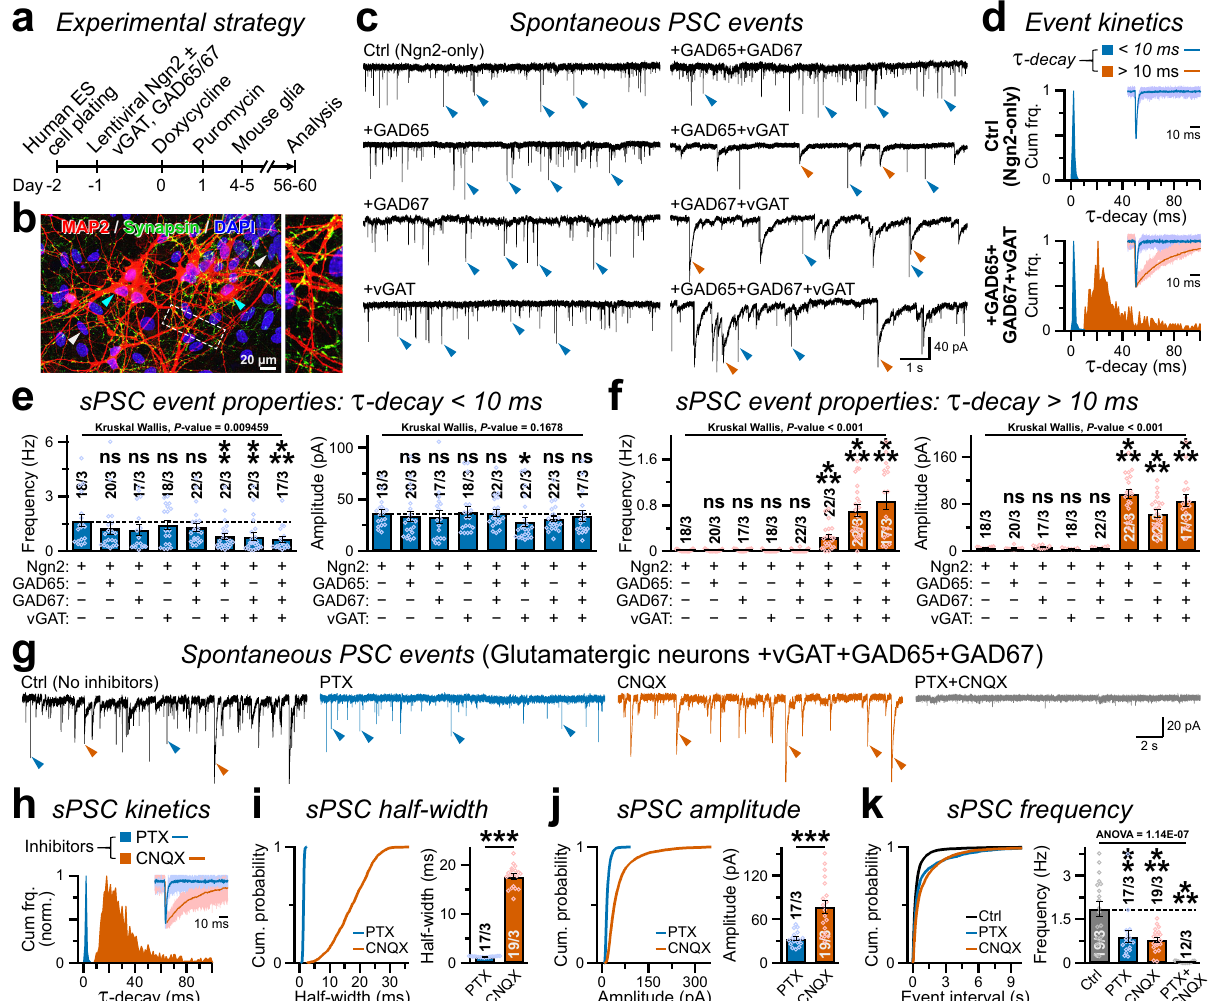
Fig. 1 Enzymatic synthesis and synaptic release of GABA by de fi ned factors. a Neurogenesis was induced in H1-ES cells by lentiviral Ngn2 expression, co- infected with additional viruses encoding vGAT, GAD65, and/or GAD67; neurons were co-cultured with mouse glia and analyzed at day 56 – 60. b An example image of Ngn2-induced human neurons (cyan arrowheads) co-transduced with V57 factors, immunolabeled for MAP2, Synapsin, and stained for nuclear DAPI (white arrowheads). The MAP2-negative and DAPI-stained population indicate co-cultured mouse glial cells. Inset, dotted box magni fi ed on right. c , d Sample traces of sPSCs recorded from indicated conditions c , and normalized cumulative frequency of τ -decays d for fast vs. slow (blue vs. red arrowheads) events. Insets in d , example waveforms of 10 scaled and overlaid sPSCs (light shade) with corresponding averages (dark shade) for control (top) vs. V57 (bottom). e , f Average frequency (left) and amplitude (right) of sPSC events with fast ( e , τ -decay < 10 ms) vs. slow ( f , τ -decay > 10 ms) decay kinetics, as recorded from human neurons expressing indicated factor combinations. g , h Representative traces g and cumulative histogram of τ - decay h of sPSCs recorded from Ngn2-neurons co-expressing V57 factors, before (Ctrl) and after acute treatments with PTX and/or CNQX (as annotated). i – k . Cumulative probabilities (left) and average values (right) of sPSC half-width ( i ), amplitude ( j ), and event frequency ( k ), measured in the absence (Ctrl) or presence of inhibitors, PTX, CNQX, or both PTX + CNQX. All data are presented as means ± SEM, with number of cells patched / independent batches. Individual data-points are provided as color-matched open circles. For panels e , f , statistical signi fi cance was evaluated by Kruskal-Wallis test paired with post-hoc nonparametric Mann-Whitney U-test using Bonferroni correction (see Source Data). For i , j , k , Skewness and Kurtosis values (-2 > ≈ and ≈ < 2) suggested normal distribution, as statistical signi fi cance was weighed by two-tailed, unpaired, Student ’ s t-test, with *** P < 0.005; ** P < 0.01; * P < 0.05; ns = not signi fi cant, P > 0.05. Multiple groups in panel k were also compared by an analysis of variance (one-way ANOVA) paired with post-hoc Tukey- Kramer test, and corresponding P -values were